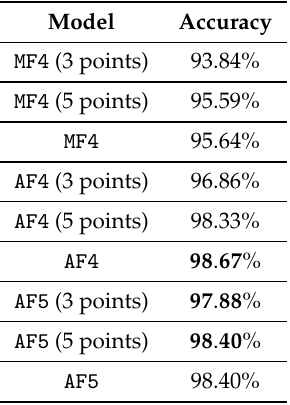
Table 6. Encodings from Section 4.2 were tested in the image classification task. Each encoding was used both in the original form, obtained as a result of local-maximum filtering, and in the reduced form that guarantees additional sparsity (Section 3.4). For each encoding ( MF4 , AF4 , and AF5 ) a separate classifier was trained. The results for the additionally thresholded data were generated with the same neural networks that were trained for the original